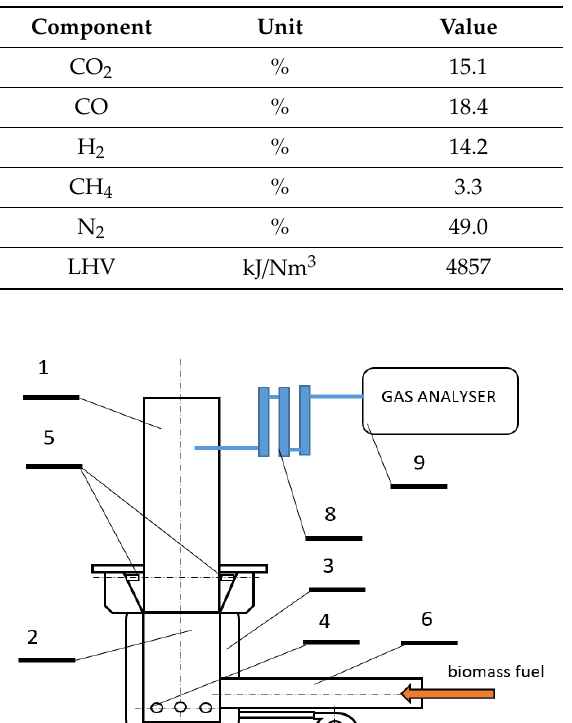
Table 2. Syngas components from biomass.